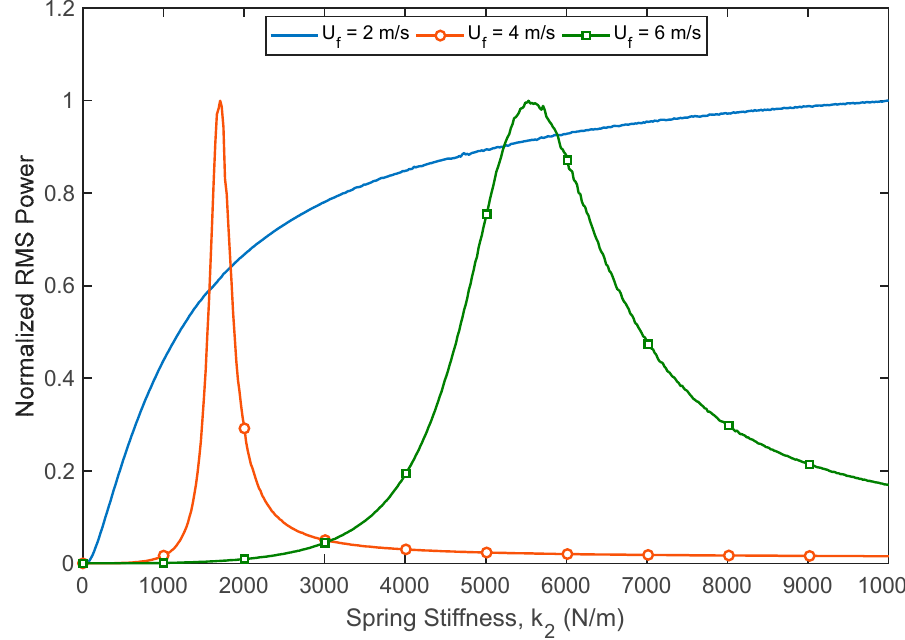
Figure 8. Turbine output power as a function of the tuning spring stiffness at different wind speeds.